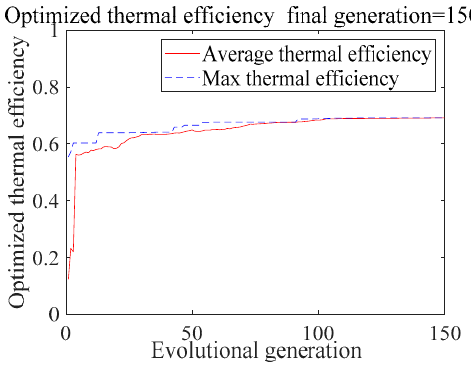
Figure 10. Optimizing process of genetic algorithm. Table 5. Optimized combustion control parameters.